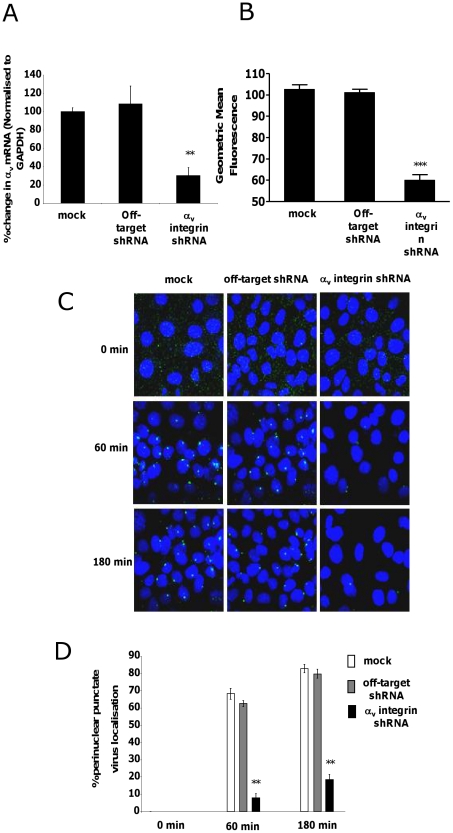
Effect of shRNA depletion of αv integrin on FX mediated Ad5 transport.Knockdown of αv integrin mRNA and protein expression levels in SKOV3 cells was quantified by qPCR (A) and flow cytometry (B), respectively. The effect of shRNA depletion on Ad5 trafficking in SKOV3 cells was assessed as previously. Representative images are shown (B) and quantification of peri-nuclear Ad5CTL localisation was calculated by analysis of 5 separate microscope fields per experimental condition (C). **p<0.05 vs both control conditions. (D) Percentage of SKOV3 cells with colocalisation of fluorescently-labelled Ad5CTL in the perinuclear region was calculated by analysing at least 5 separate 40× microscope fields per experimental condition. ** = p<0.01 compared to off target shRNA values, error bars represent S.E.M.